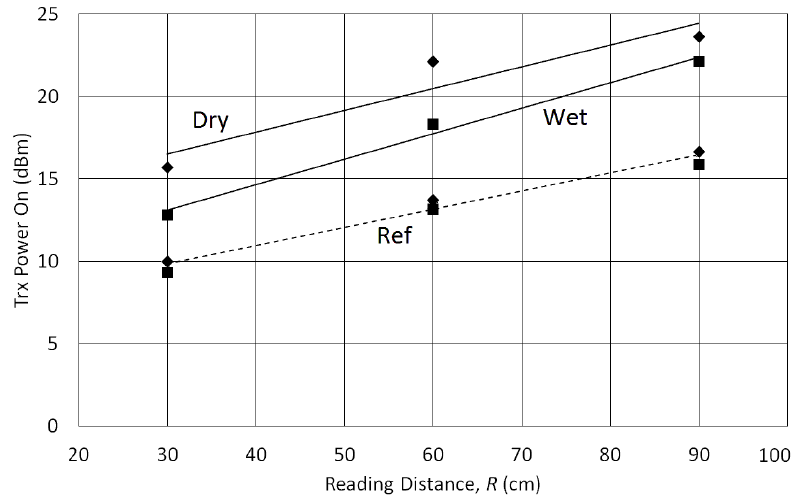
Figure 5. Transmission power to turn on the tags (for 868 MHz) as a function of the reading distance between tags and reader ( R ). Solid lines are for Sensor Tag and dashed line for Reference Tag. Diamonds are for dry soil and squares are for wet soil.